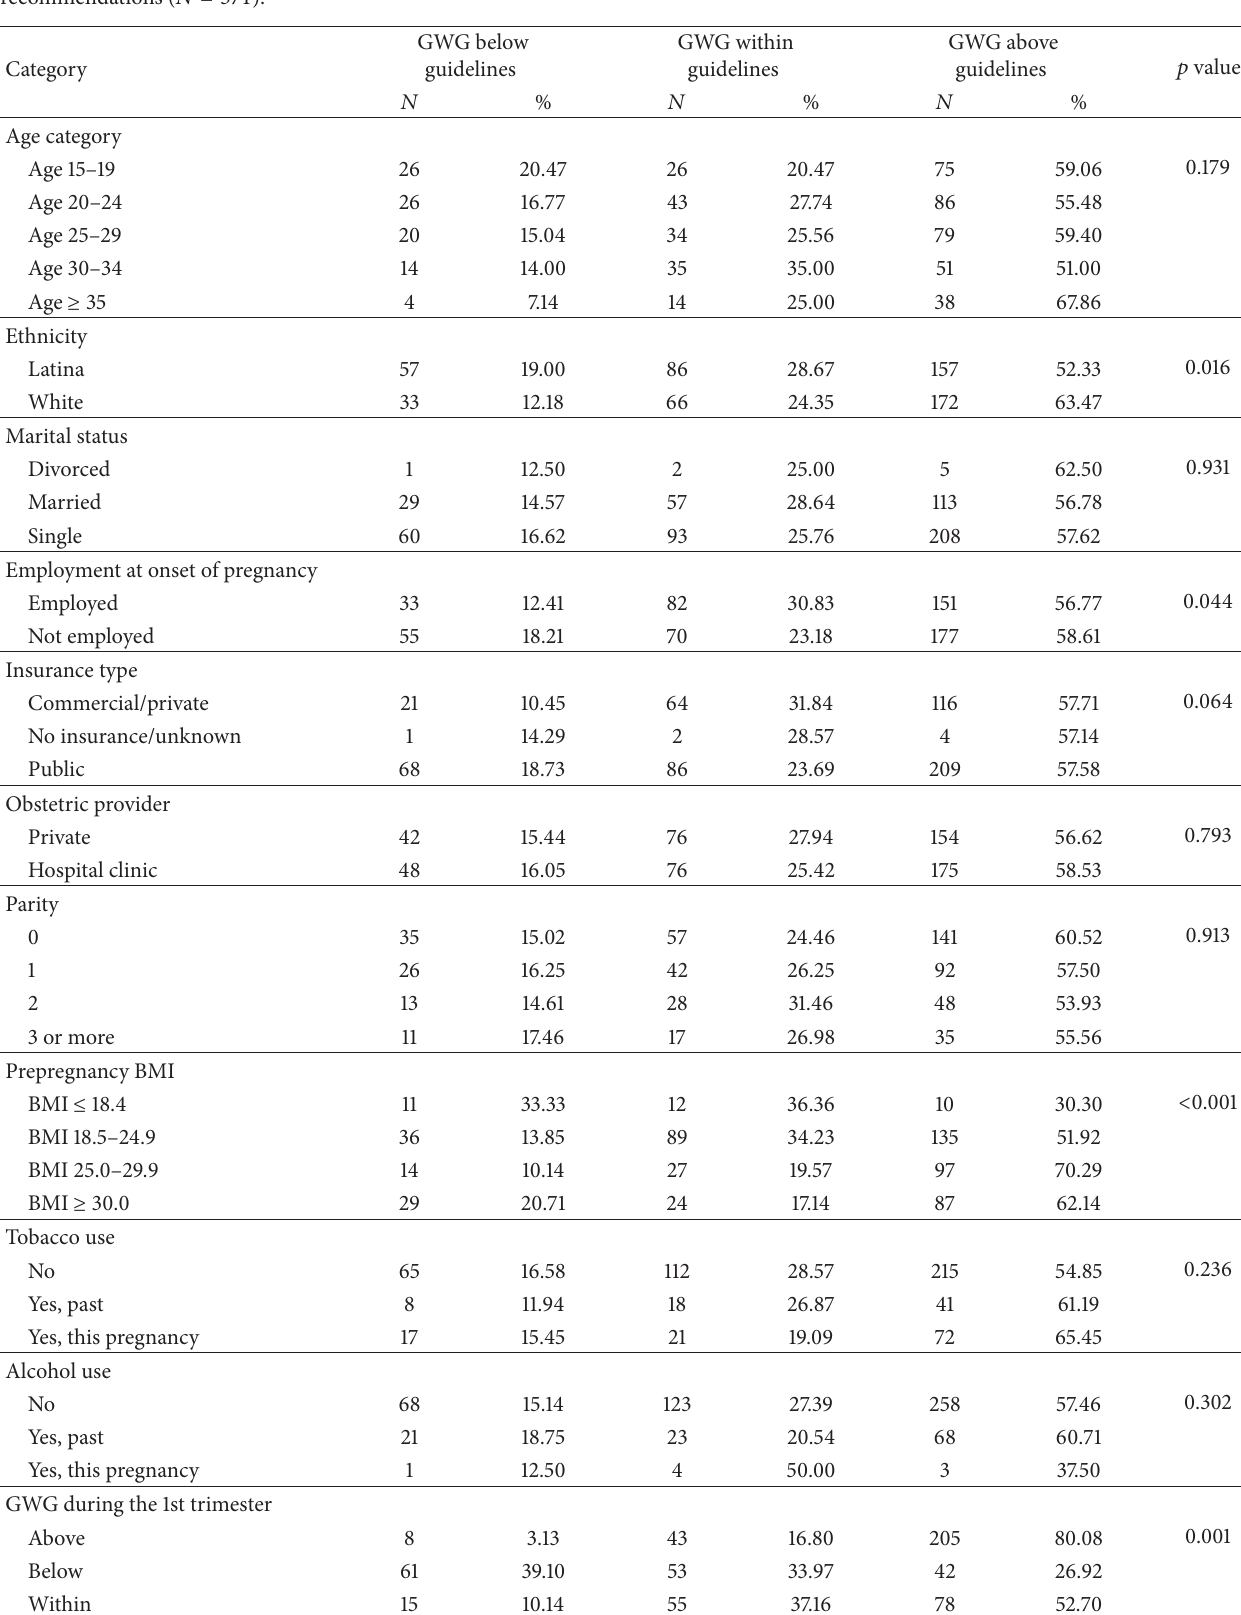
Table 2: Univariate associations of demographic, behavioral, and psychological factors and gestational weight gain status based on 2009 IOM recommendations ( 𝑁 = 571